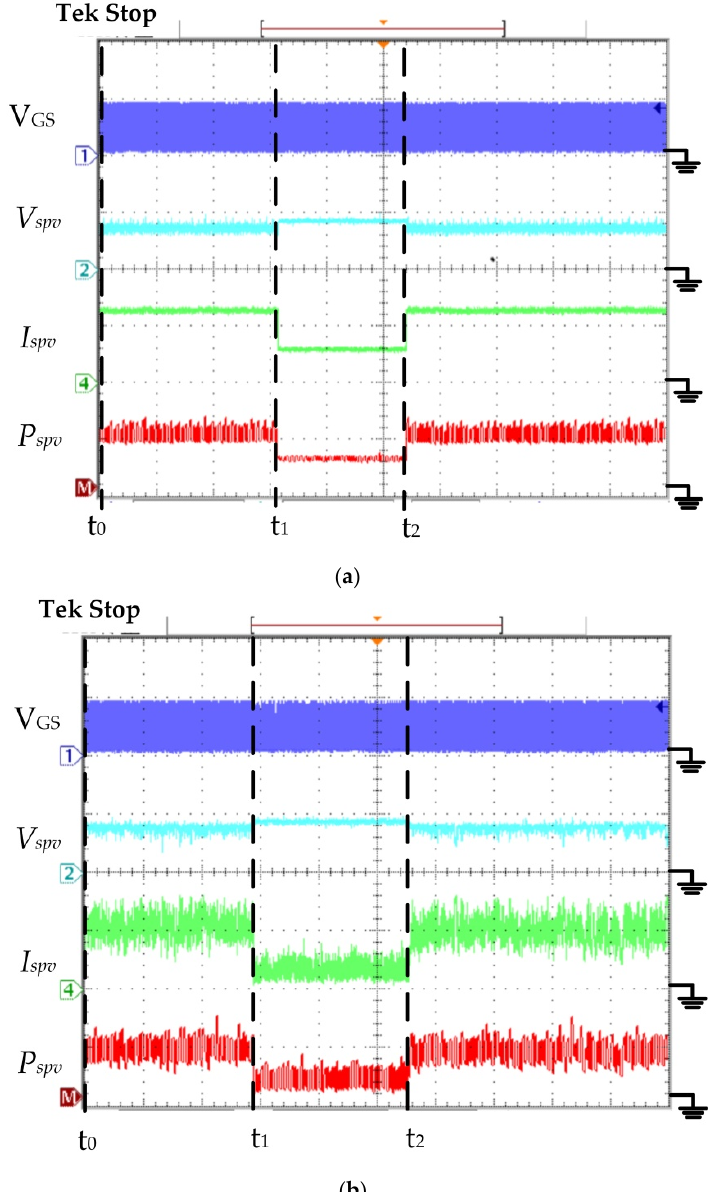
Figure 8. V GS , V spv , I spv and P spv waveforms for a SPV module under a T of 25 °C and varying irradi ‐ ance of 500 W/m 2 to 220 W/m 2 then to 500 W/m 2 : ( a ) the proposed algorithm and ( b ) the P&O algo ‐ rithm. (V GS : 20 V/div; V spv : 10 V/div; I spv : 1 A/div; P spv : 10 W/div; Hor: 4 s/div).